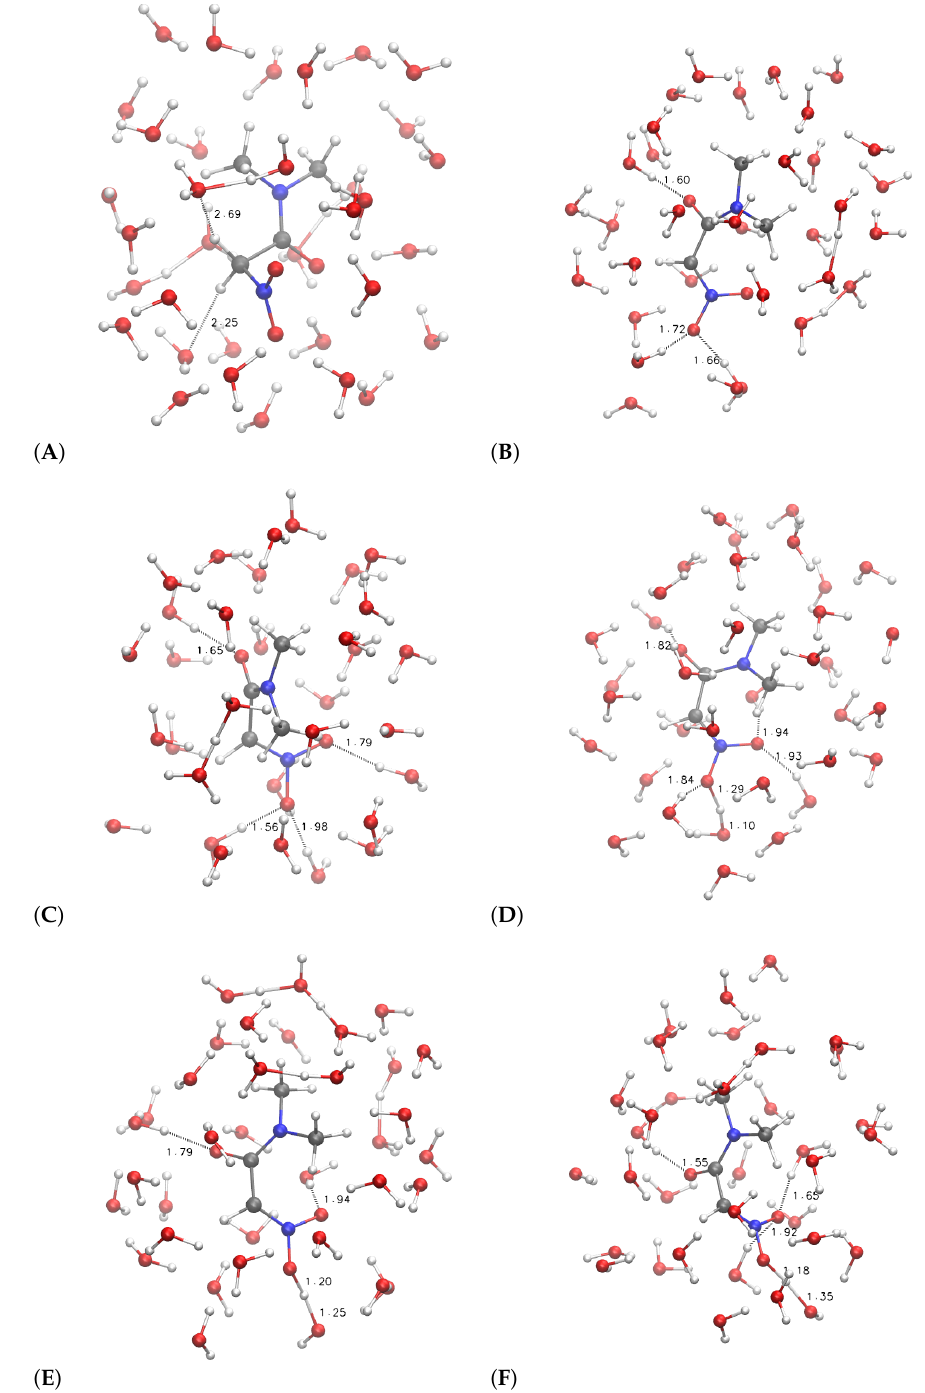
Figure 7. The same as Figure 6 when R = (CH indicated with A–F in Figure